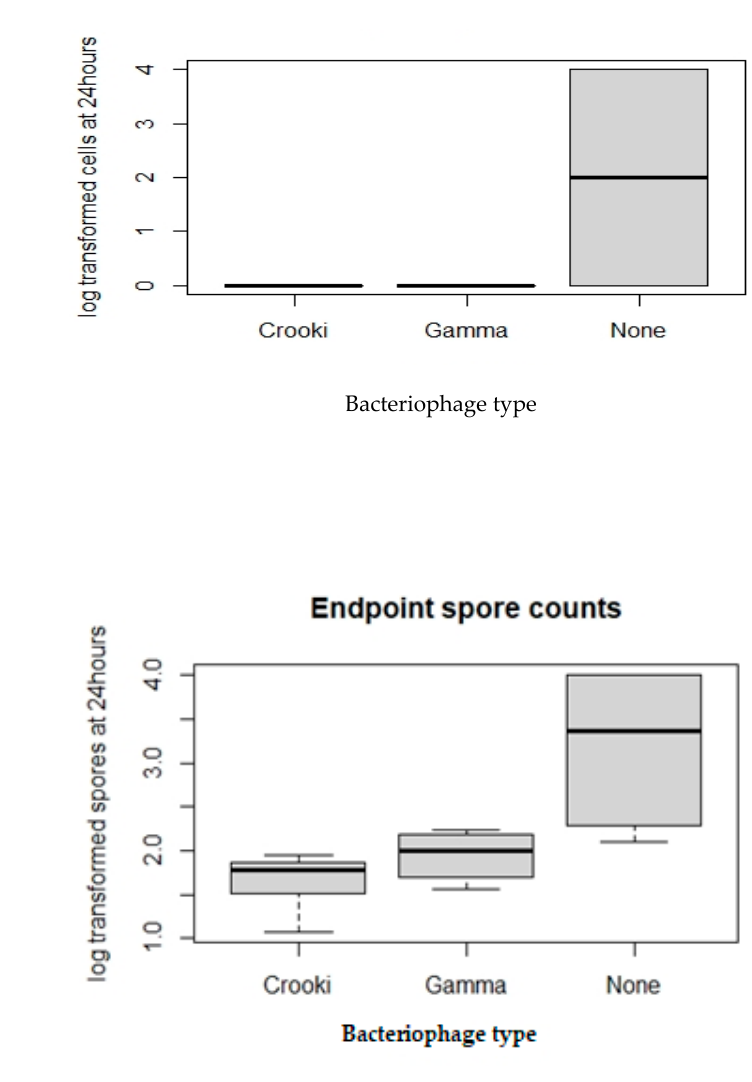
Figure A3. (A) : Endpoint Sterne vaccine strain cell counts in the presence and absence of B. anthracis phages Crookii and Gamma. ( B ): Endpoint Bacillus anthracis spore counts when inoculated with phages Crookii and Gamma. (B) : Endpoint Bacillus anthracis spore counts when inoculated with B. B. anthracis phages. anthracis phages. Figure A4A–D: Absence of phages increases cells and spore counts regardless of bacterial strain ( Bacillus anthracis DS201579 and Sterne 34F2)